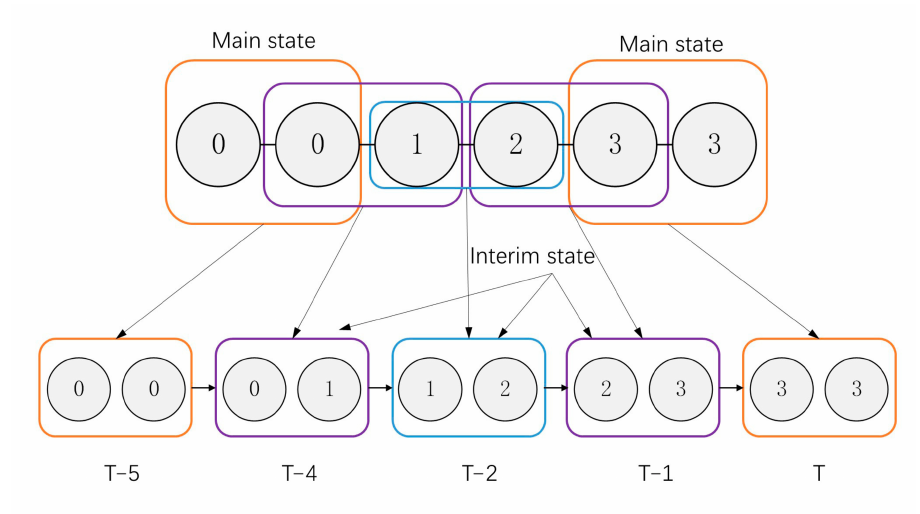
Figure 3. Schematic diagram of main state transition